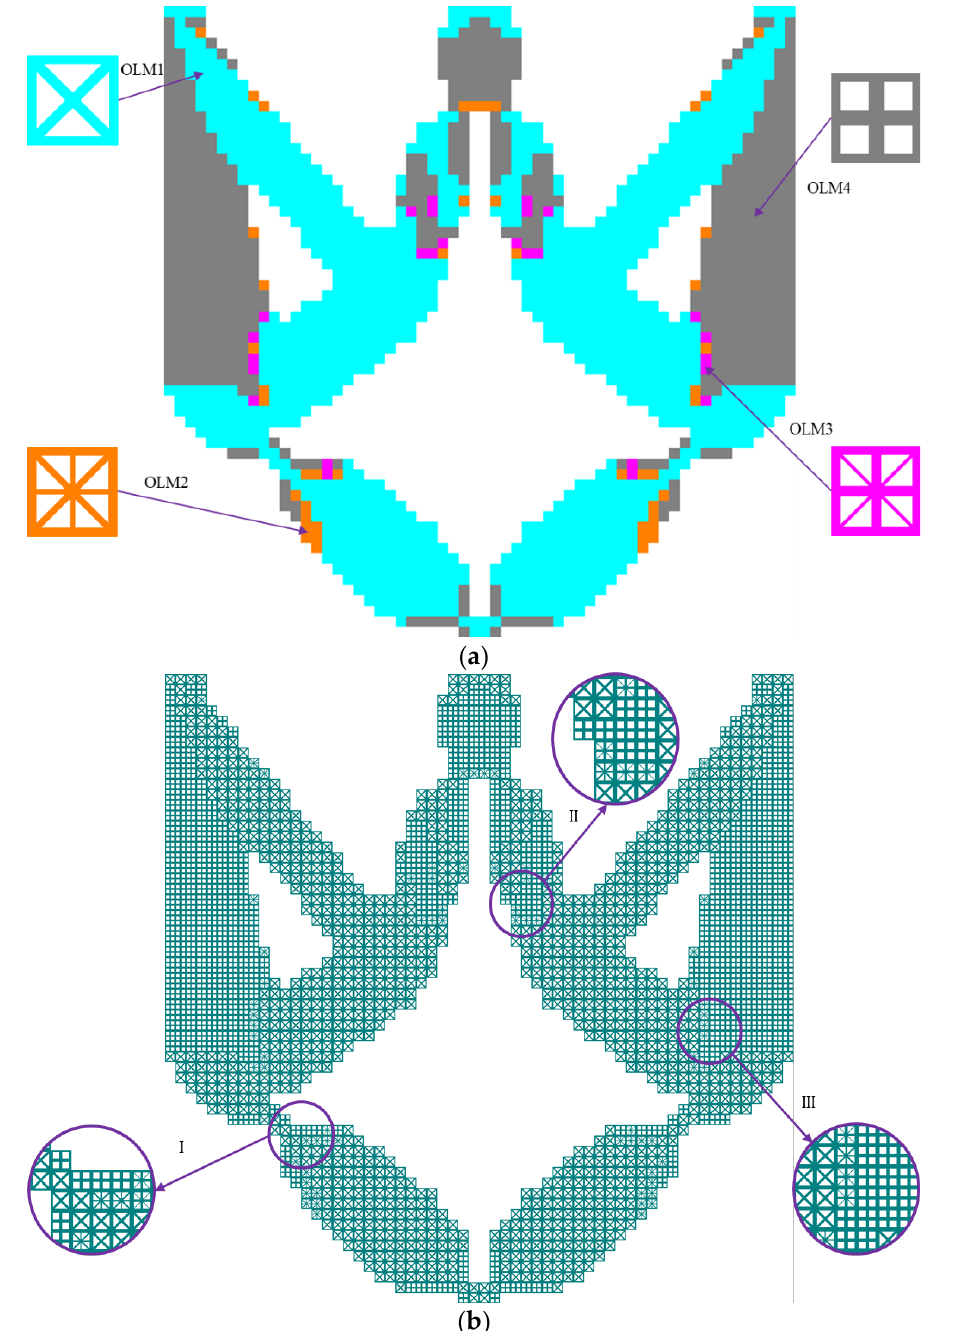
Figure 5. Optimized result of the DIM: ( a ) different OLMs ’ distribution; ( b ) optimized HL-DIM with partial enlargement areas I, II and III.